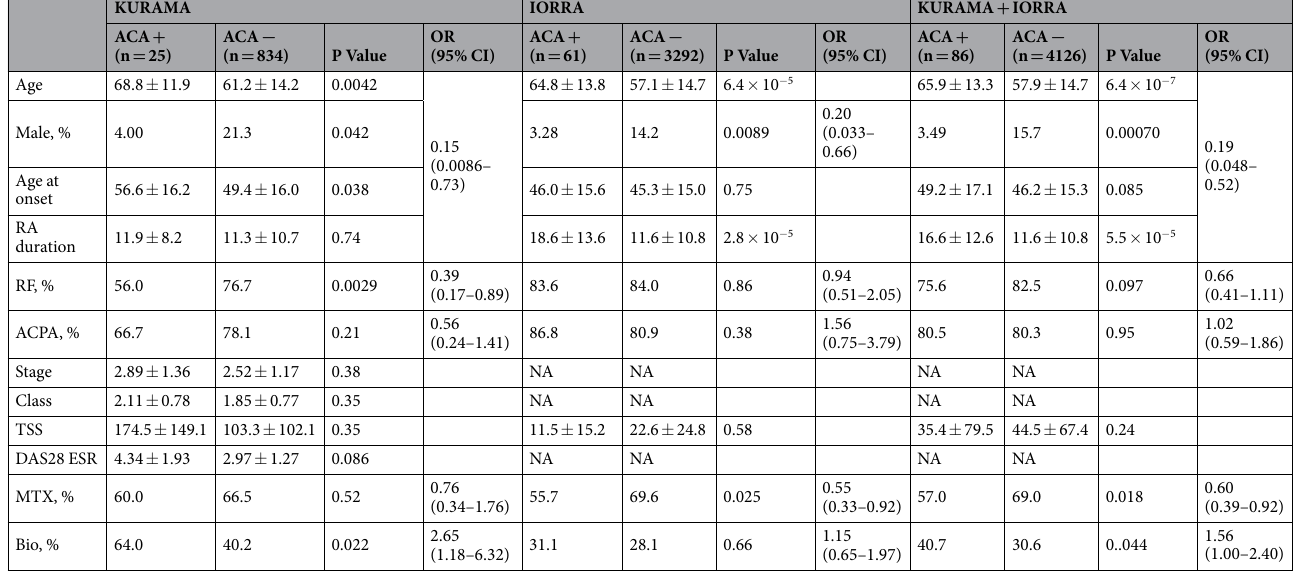
Table 1. Clinical features of ACA-positive RA patients. KURAMA, Kyoto University Rheumatoid Arthritis Management Alliance; IORRA, Institute of Rheumatology, Rheumatoid arthritis; ACA, anti-centromere antibody; OR, odds ratio; 95% CI, 95% confidence interval; RA, rheumatoid arthritis; TSS, total sharp score; DAS, disease activity score; ESR, erythrocyte sedimentation rate; MTX, methotrexate; Bio: biologic therapy; NA, not applicable. mean ± standard deviation is indicated for quantitative